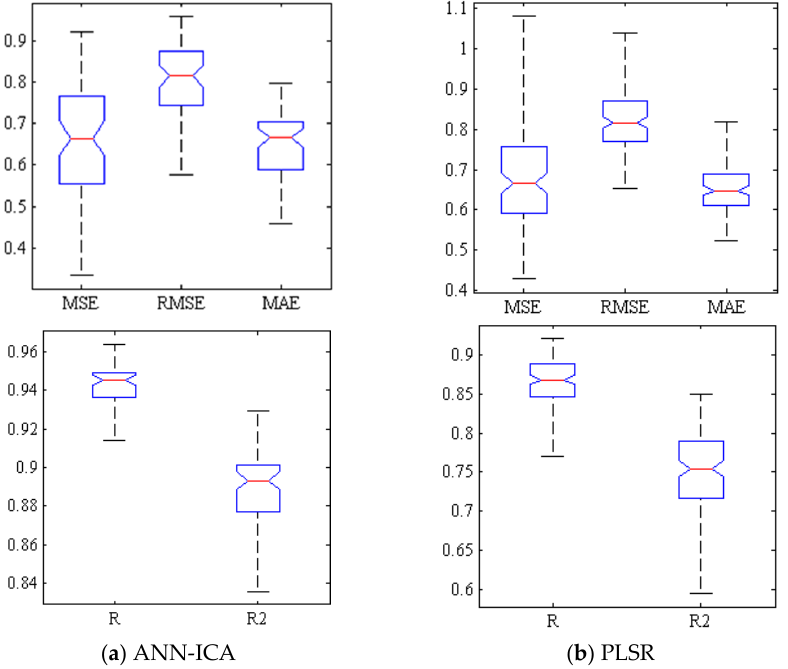
Figure 5. Box diagram of error criteria (1st row) and coefficients of correlation and determination (2nd row) related to ANN-ICA and PLSR in prediction of BrimA.